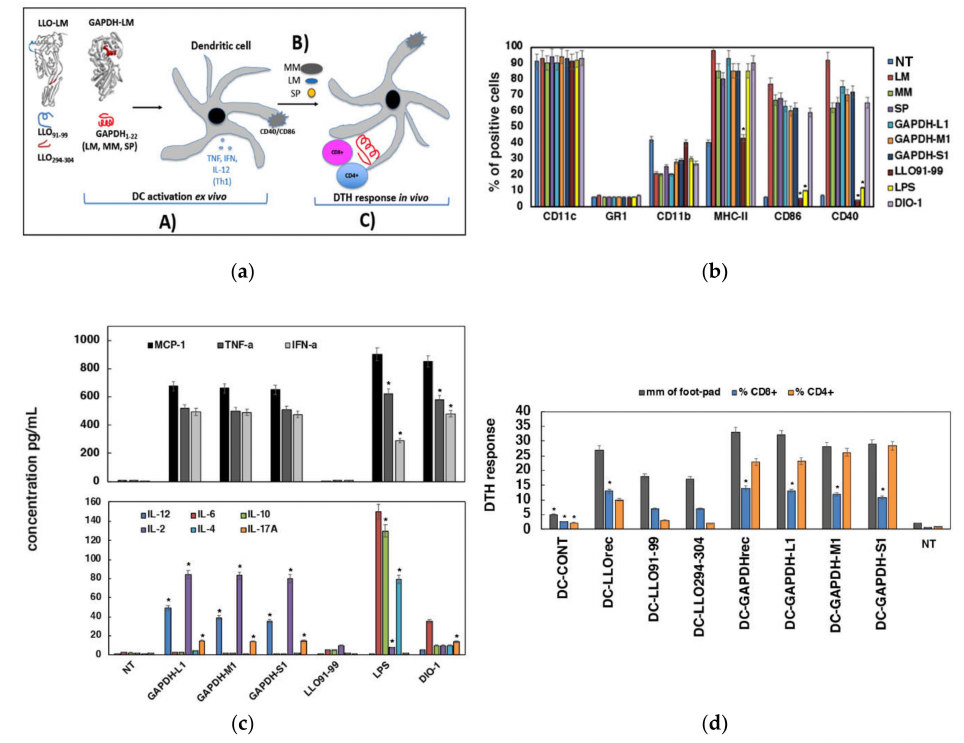
Figure 2. GAPDH-L1, GAPDH-M1 and GAPDH-S1 peptides elicited similar immune responses in DC vaccine vectors. ( a ), Scheme of the approach we have used to examine the efficiency of DC vaccines. First, DC were loaded ex vivo with the antigens to explore DC activation, percentages of CD40 + and CD86 + positive cells and levels of Th1 cytokines released to supernatants (strategy A). Second, mice were challenged i.v. with the bacteria, LM, MM or SP (strategy B). Third, mice were inoculated with DC vaccines into the left hind footpads, DTH responses were measured and popliteal lymph nodes isolated to analyze T cell populations (strategy C). ( b ) , Flow cytometry analysis of DC surface markers after incubation with GAPDH-L1, GAPDH-M1 and GAPDH-S1 peptides. Results indicate the percentages of CD11c + , MHC-II + , CD40 + or CD86 + positive cells. Results are the mean of three different experiments ± SD. Student t -test was applied for statistics. * p < 0.05. ( c ), Cytokine levels released to the supernatants of DC as in (b). Cytokine are measured with a multiparametric CBA kit (BD Biosciences). Results are expressed as pg/mL of each cytokine ± SD of triplicate samples. ANOVA test was applied. * p ≤ 0.05. ( d ), C57BL/6 mice were immunized i.v. with 5 × 10 3 CFU/mice and then left hind footpads were inoculated with 1 × 10 6 DC vaccines, DC-LLO rec , DC-GAPDH rec , DC-GAPDH-L1, DC-GAPDH-M1, DC-GAPDH-S1, DC-LLO 91–99 , DC-LLO 294-304 , empty DC or saline (NT) in the presence of 25 µ g/mL of DIO-1, while right hind footpads are not inoculated to serve as controls. Footpad swelling was measured with a caliper (grey bars) and expressed as the differences in mm between left and right hind footpads. Results are the mean ± SD of three different experiments. Student t -test was applied for statistics. * p < 0.05 compared to empty DC samples. Popliteal lymph nodes were isolated from inoculated mice legs and after homogenization, T cells sub-populations were analyzed by flow cytometry. Percentages of CD4 + (orange bars) or CD8 + T cells (blue bars) are shown. Results are expressed as the percentages of positive cells ± SD of three different experiments. ANOVA test was applied. * p < 0.05 compared to empty DC